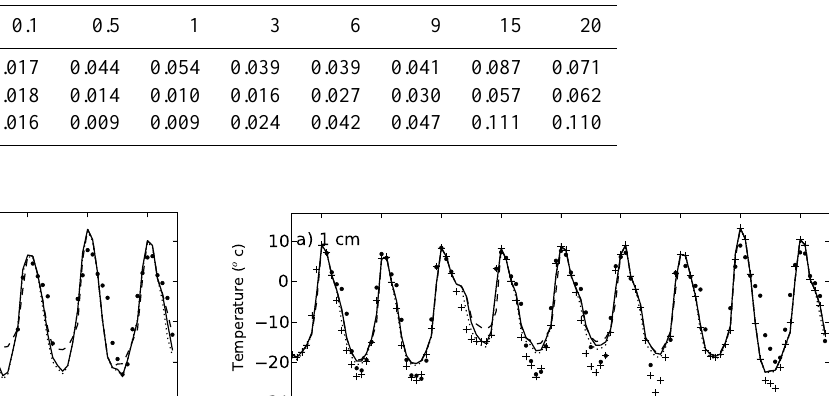
Table 5. The root mean squared error ( n = 36500) between the temperatures ( ◦ C) from exact Neumann solutions and simulated temperatures from the DOS-TEM for different materials, with 5000m total thickness and bottom-up forcing at 1m below the thawing front, at depths of between 0.05 and 20m.